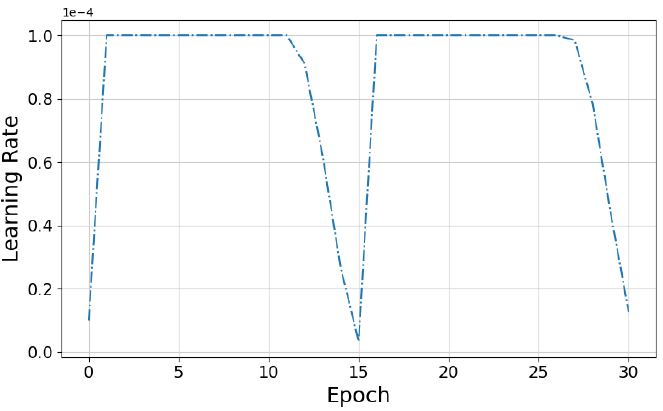
Figure 6. Flat + Cosine anneal learning rate curve used for